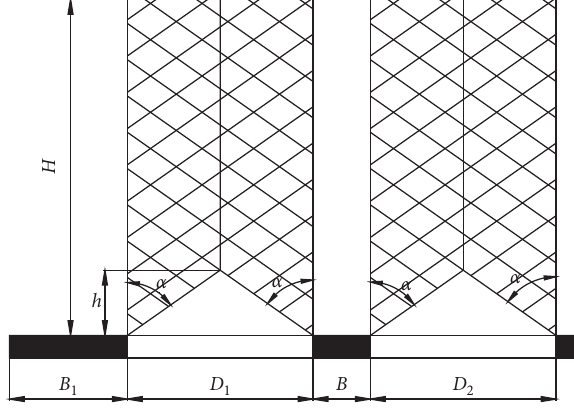
Figure 3: Estimation model of overlying coal seam